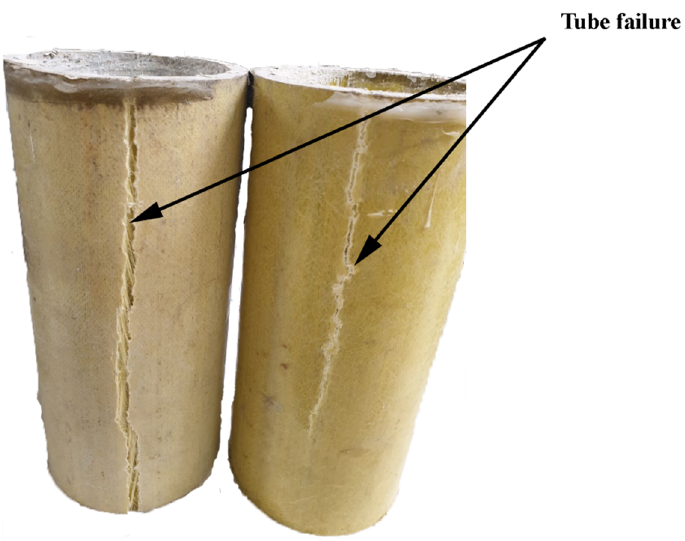
Figure 8. Longitudinal resin–fibre interface tube failure in a pushout test of SWSSC pultruded GFRP tubes [44].